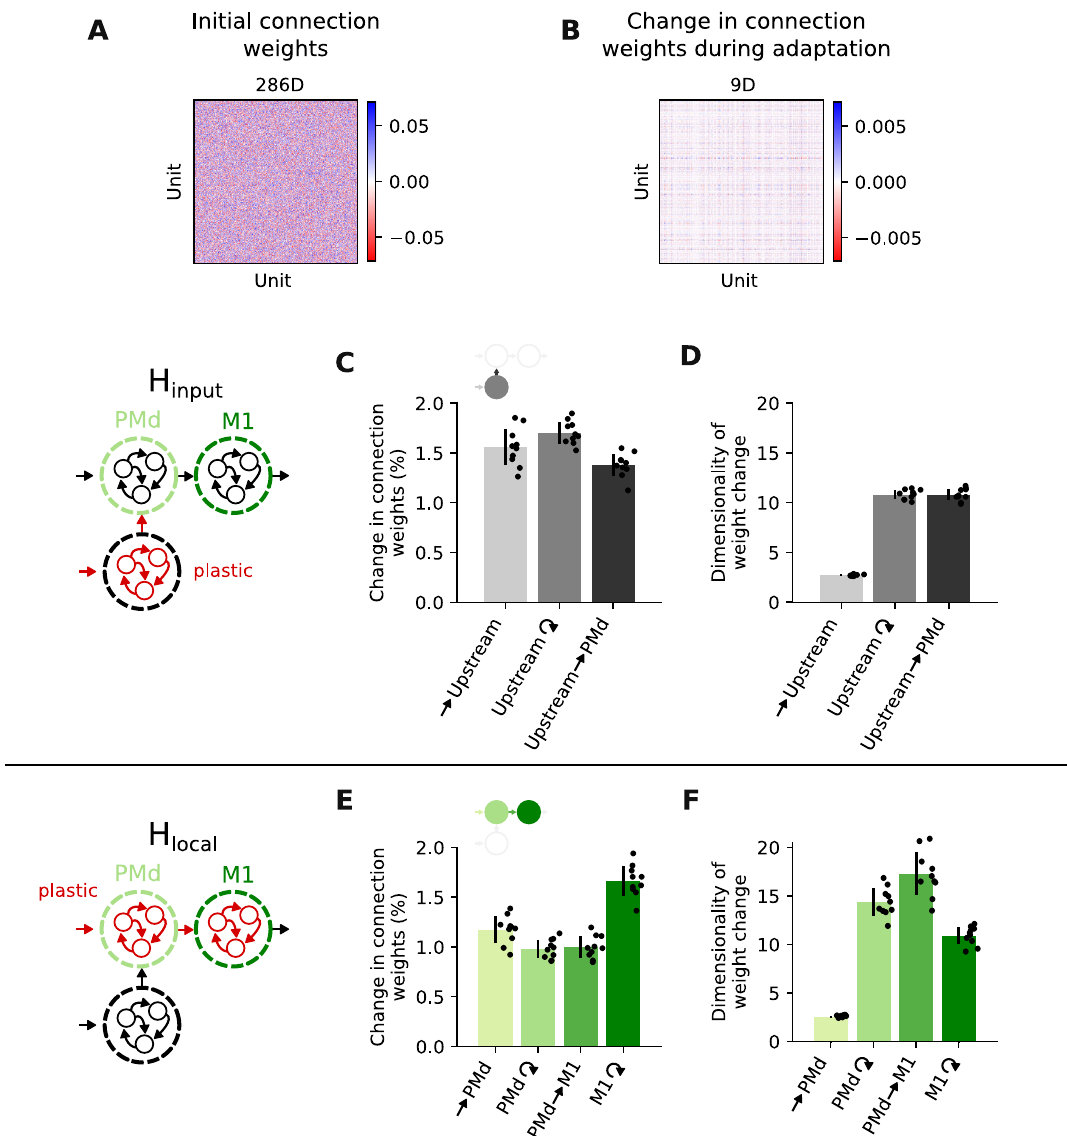
Fig. 5 | Small but coordinated connectivity changes enable motor adaptation. A Example connection weights for the M1 module after initial training. Top: esti- mated dimensionality. B Example changes in M1 connection weights following VR adaptation under H local . Same format as ( A ). C Change in connection weights